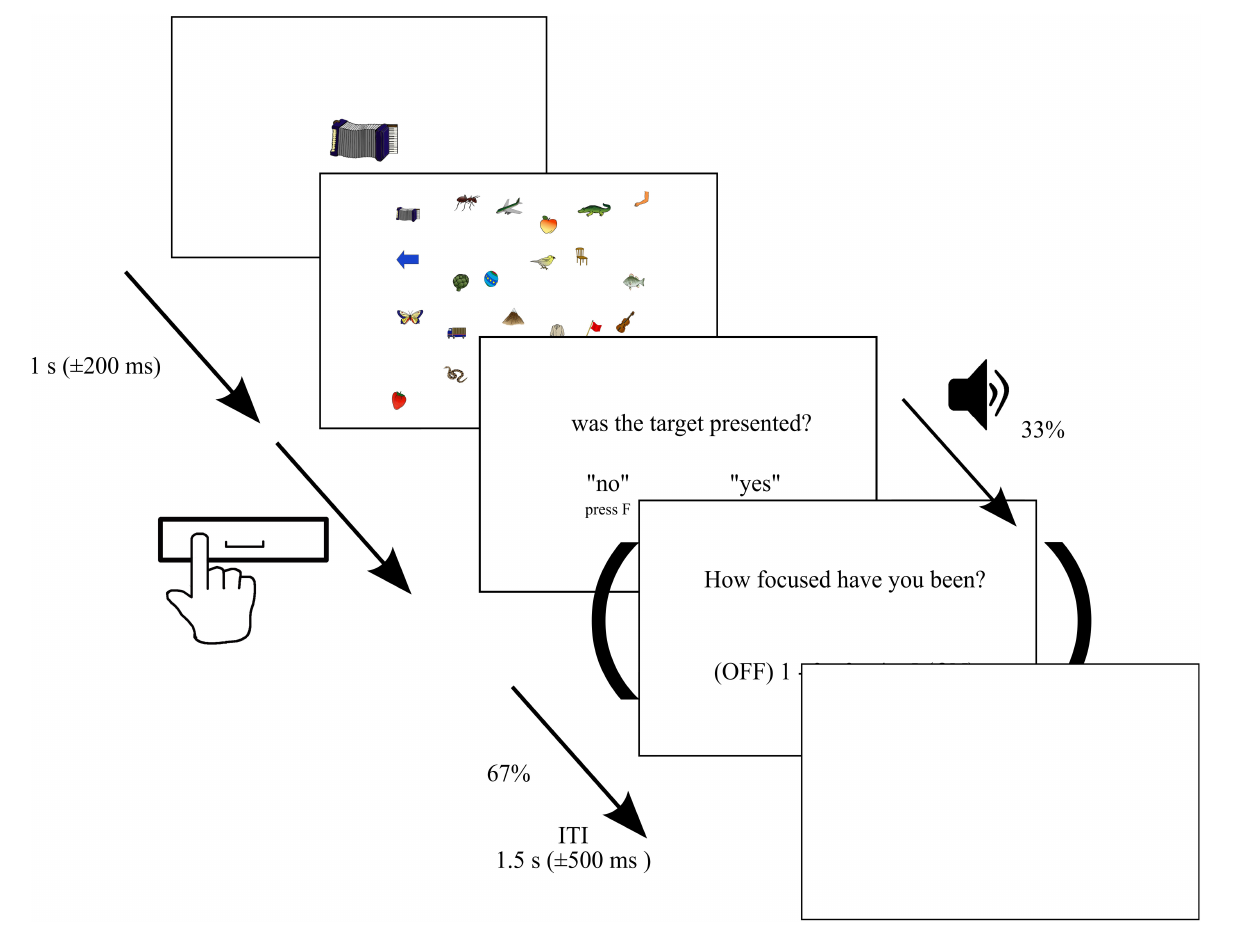
FIGURE 1 | Paradigm. Depiction of the paradigm. Each trial started with the presentation of a target presented at the center of the screen for 1 s ( ± 200 ms) immediately followed by a visual search display consisting of 24 randomly selected objects. In 80% of the trials, the search display contained the target, while in the remaining 20%, the target was not presented. Each of the 250 stimuli served as a target three times across the entire experiment. Subjects were instructed to search the visual display and press the space bar when the search terminated (target found or verified that no target was presented). The display was switched off upon pressing the space bar or remained presented for a maximum of 14 s. Afterward, they were asked to press the “J” key with the right index finger when the target was presented or the “F” button with left index finger when the target was not presented. In 33% of trials, we delivered thought probes initiated by an auditory stimulus asking participants to rate their attentional focus, in the period immediately prior to the probe, on a 5-point scale from 1 (”thoughts were anywhere else”—OFF) to 5 (“thoughts were totally at the